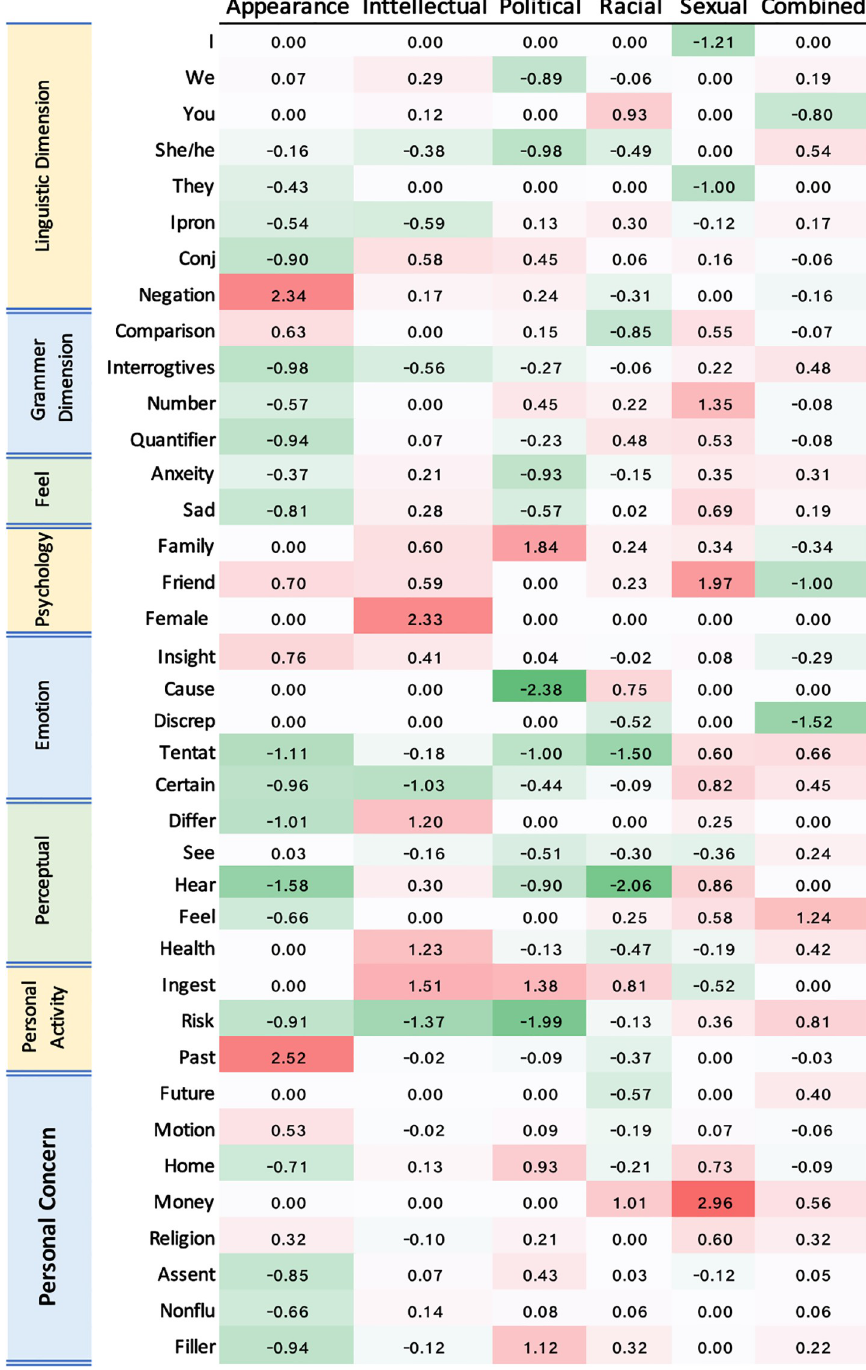
PLOS ONE | https://doi.org/10.1371/journal.pone.0227330 March 27,